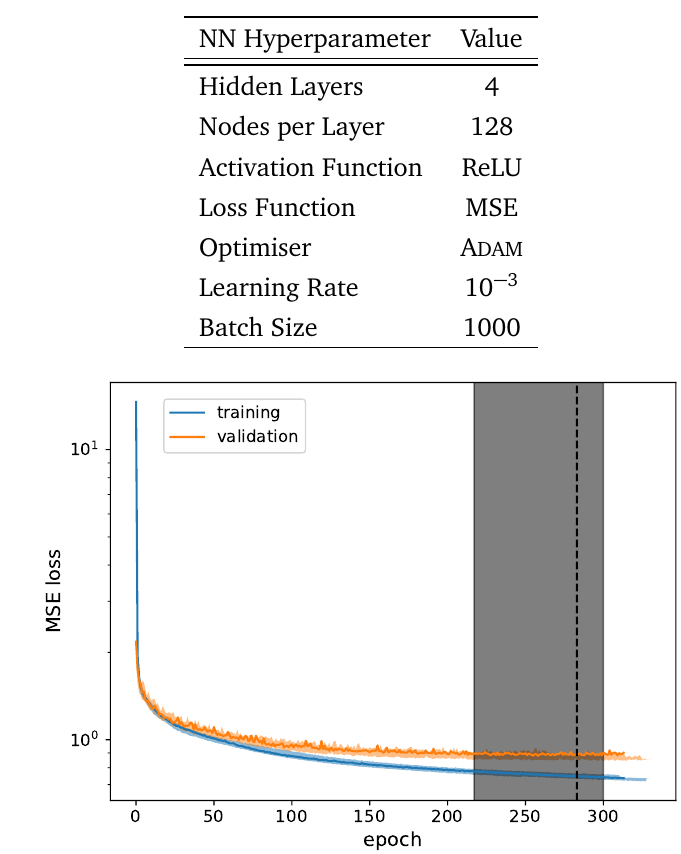
Table 1: Summary of hyperparameters specifying the employed feedforward NN ar- chitecture and the means of training.